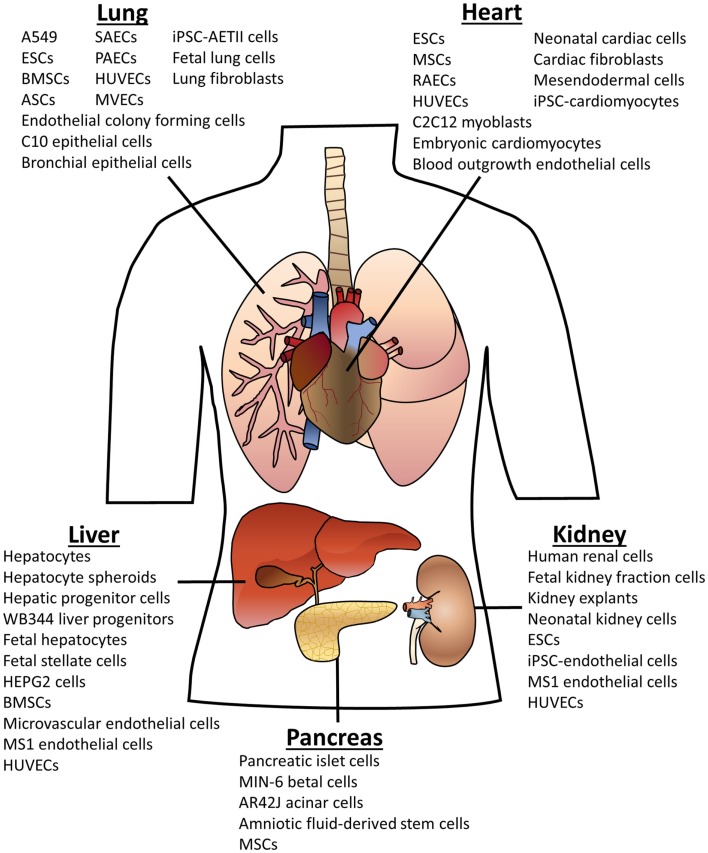
Cell types used for organ scaffold recellularization. The cells listed above have been reportedly used for recellularization of the specified organ. Abbreviations: embryonic stem cells (ESCs); bone marrow-derived stem cells (BMSCs); adipose-derived stem cells (ASCs); mesenchymal stem cells (MSCs); induced pluripotent stem cells (iPSCs); human umbilical vein endothelial cells (HUVECs); small airway epithelial cells (SAECs); pulmonary alveolar epithelial cells (PAECs); microvascular endothelial cells (MVECs); alveolar epithelial type II cells (AETII).